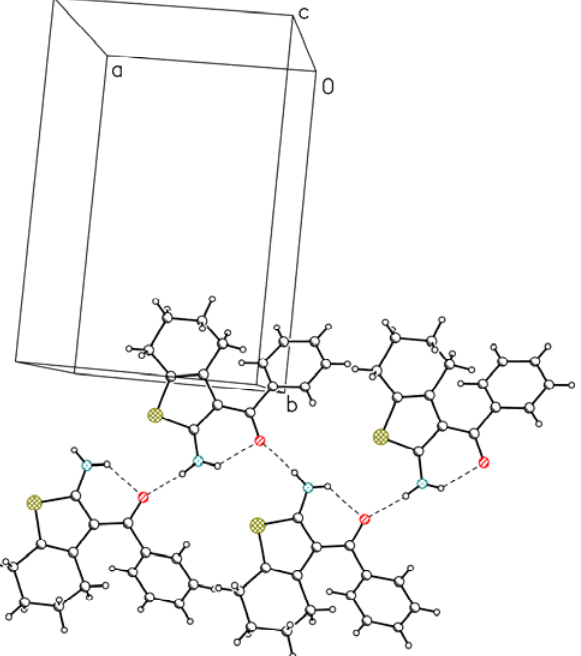
Figure 3. Hydrogen-bond chain of molecule 1 [12]. Hydrogen bonds are depicted as dashed